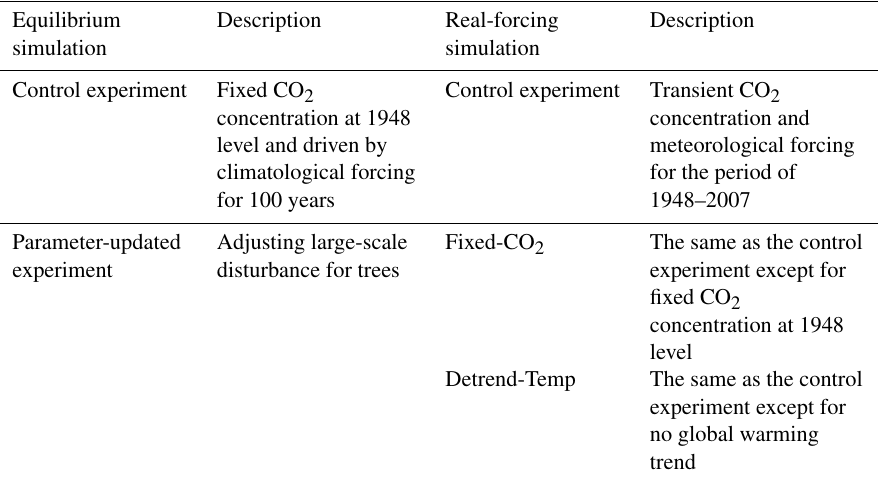
Table 1. Experimental